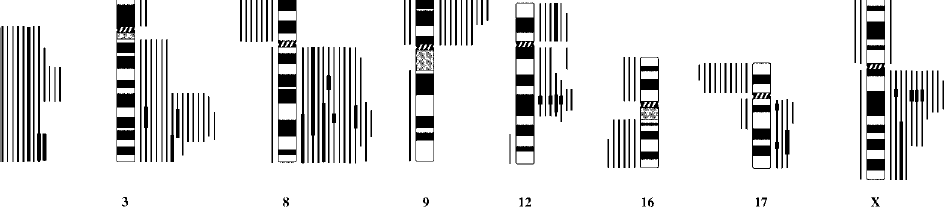
Fig. 2. The most pronounced differences in chromosomal rearrangements in primary breast carcinomas from long-term survivors (A) and short-term survivors (B). Bars on the right side of the chromosome ideogram indicate gains and bars on the left side indicate loss of chromosomal material. High copy number alterations are marked by bold